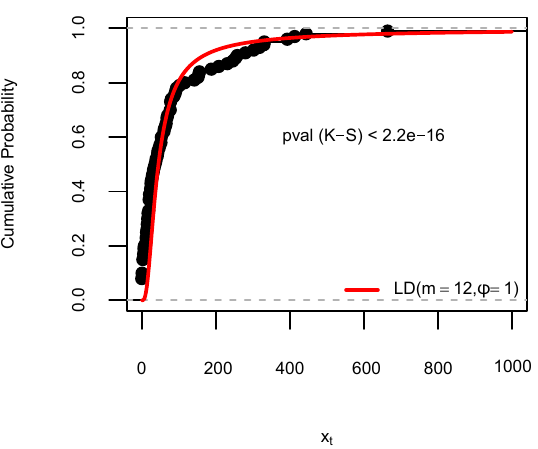
Figure A1. Empirical cumulative distribution (ECDF) function of the number of mutant cells x t in Simulation S1c, based on 100 data samples generated by SimuBP. The time of plating t p = 11. The red curve represents the cumulative distribution function of the Luria–Delbrück distribution in comparison. The Kolmogorov–Smirnov (K-S) test p -value is shown under the ECDF